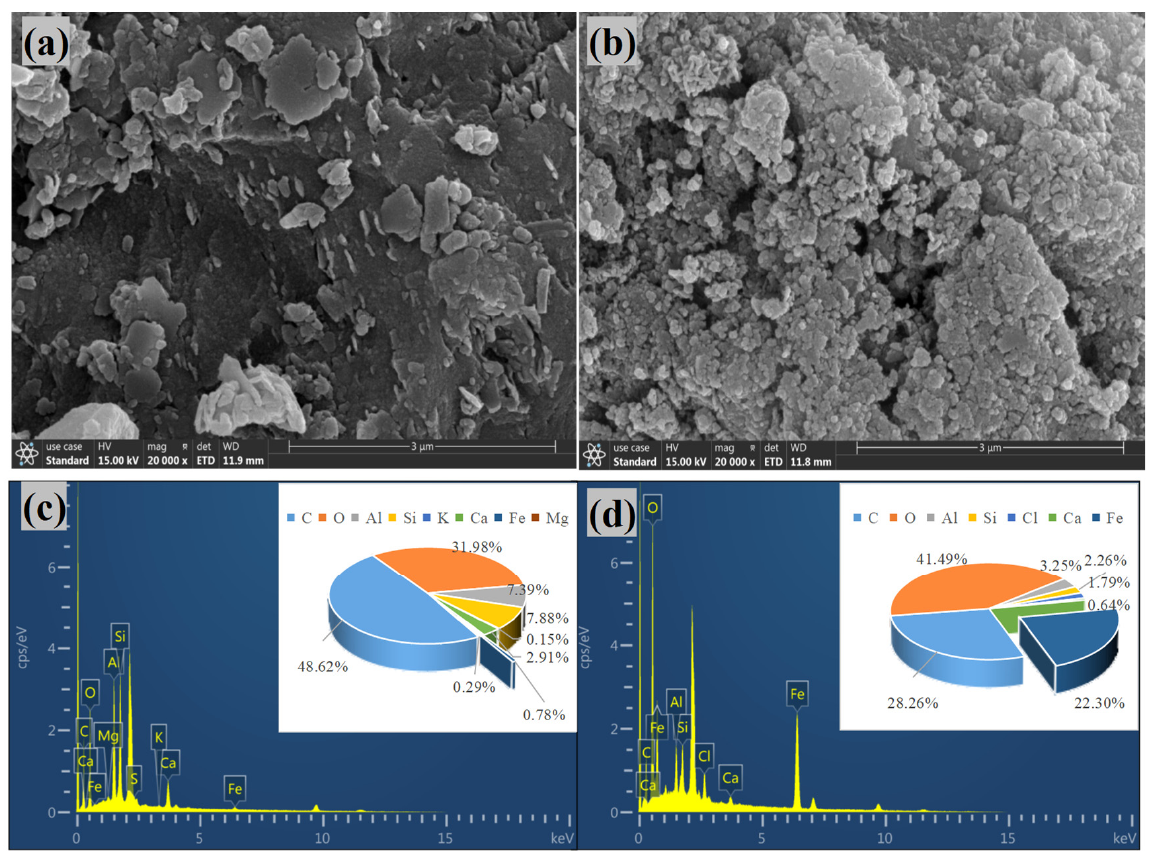
Figure 1. SEM images of ( a ) BC, ( b ) Fe 3 O 4 @BC; EDS spectrum of ( c ) BC, ( d ) Fe 3 O 4 @BC.